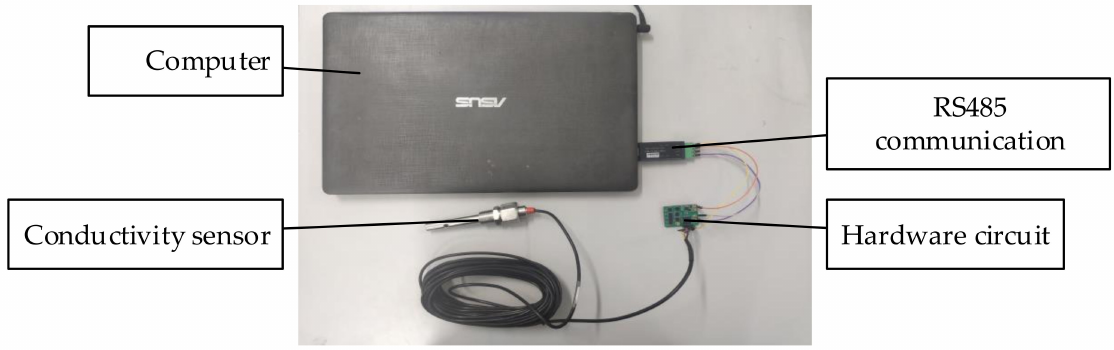
Figure 14. Image of the unsealed system.